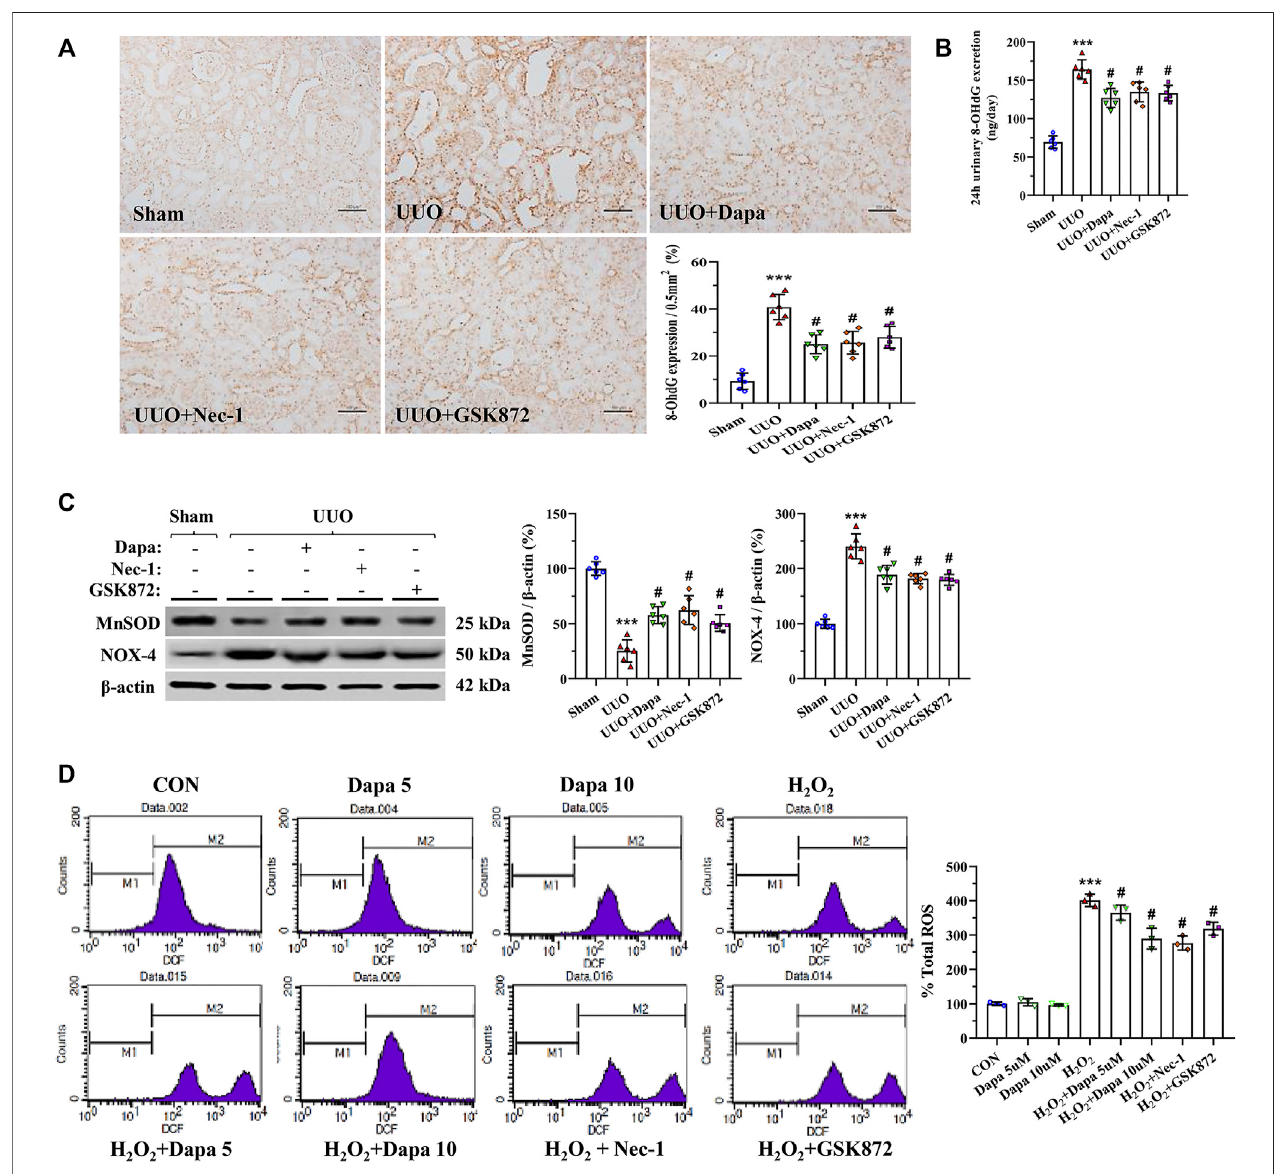
FIGURE 4 | Representative photomicrographs of immunohistochemistry for 8-OHdG (A) , urine 8-OHdG concentration (B) , immunoblotting analysis of MnSOD and NOX-4 (C) , and intracellular ROS production in H 2 O 2 -treated HK-2 cells with or without Dapa and RIP inhibitors (D) . Data are presented as mean ± SEM ( in vivo , n (cid:2) 6; in vitro , n (cid:2) 3) and analyzed by one-way ANOVA. *** p < 0.01 vs sham or control; # p < 0.05 vs. UUO or H 2 O 2 .